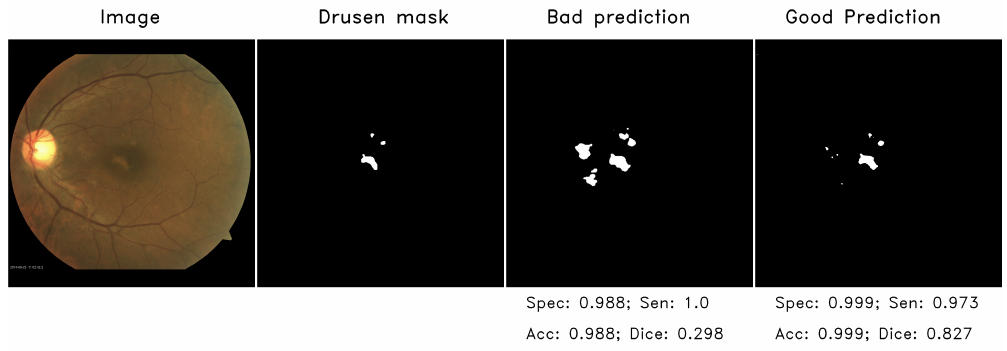
Figure 4. The comparison between specificity, sensitivity, accuracy, and Dice